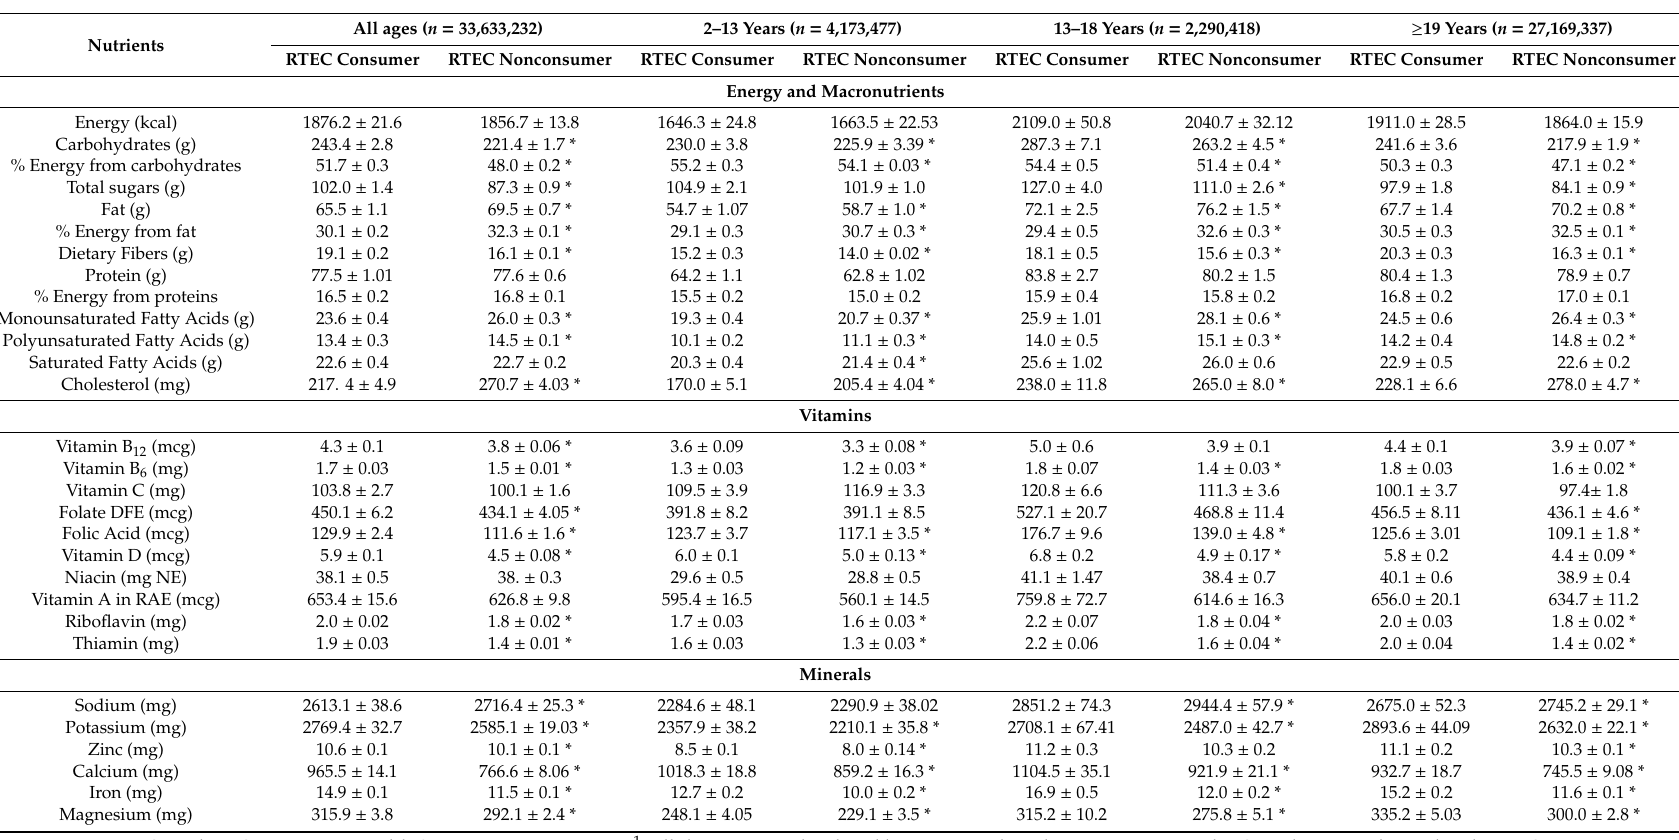
Table 3. Daily energy and nutrient intake between ready-to-eat cereal (RTEC) consumers and non-consumers by age groups 1 ; data are shown as mean ± SE. Nutrients